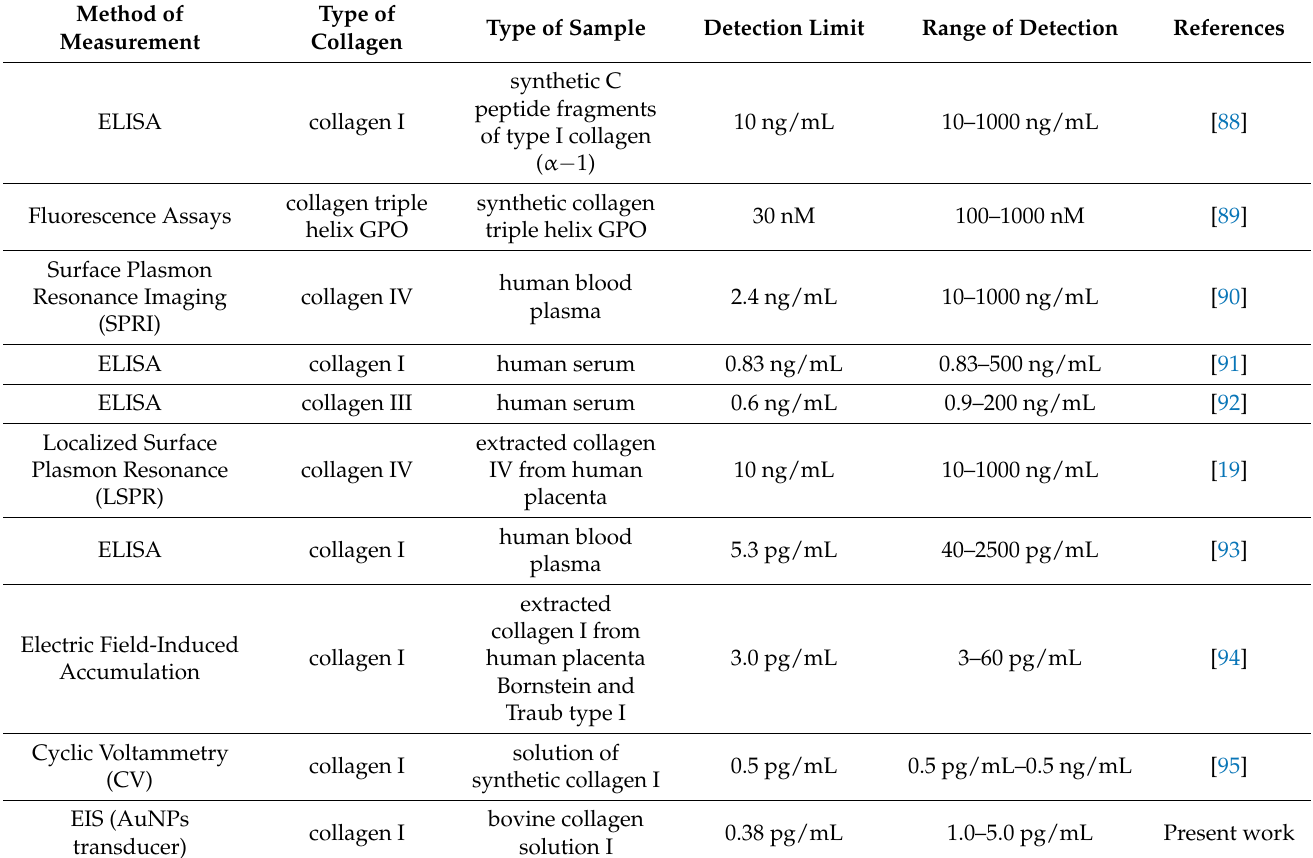
Table 2. Comparison of the different techniques for the determination of the collagen